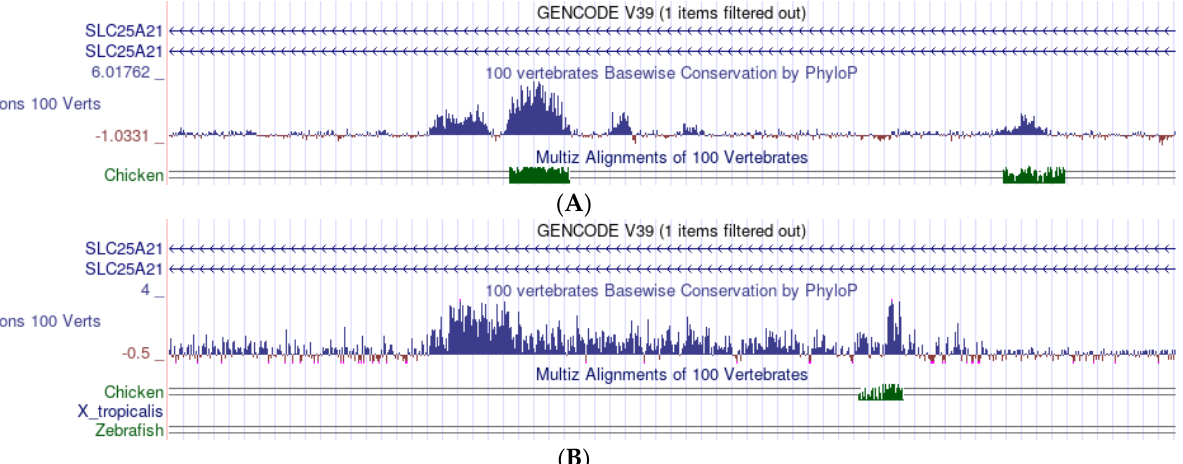
Figure 7. ( A ) A section of the SLC25A21 sequence: The general vertebrate conservation exhibits five distinct peaks, but the chicken sequence matches only two of them. This section approximately corresponds to nucleotides 36,731 K to 36,784 K in human (refers to genomic sequences; Table 2). ( B ) A section of the SLC25A21 sequence: the general vertebrate conservation exhibits a long series of conserved nucleotides, while the chicken matches only a small part of the series and zebrafish exhibits no signal at all. This section approximately corresponds in human to nucleotides 36,792 K to 36,845 K.